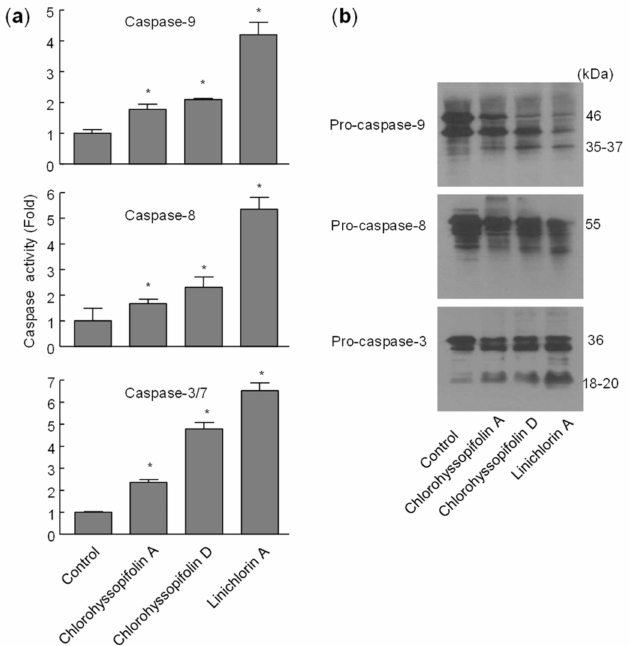
Figure 7. Chlorohyssopifolins A ( 1 ) and D ( 4 ) and linichlorin A ( 6 ) induce activation and processing of caspases in U-937 cells. ( a ) Cells were treated with 10 µ M of the indicated guaianolide, harvested at 24 h and cell lysates were assayed for caspase-9, caspase-8 and caspase-3 / 7 activities using colorimetric substrates. Results are expressed as factorial increases in caspase activity compared with the control. Values represent means ± S.D. of two independent experiments each performed in triplicate. * p < 0.05, significantly di ff erent from untreated control. ( b ) Processing of caspases in response to chlorohyssopifolins A ( 1 ) and D ( 4 ) and linichlorin A ( 6 ). Cells were incubated with 10 µ M of the indicated guaianolide for 24 h and the corresponding caspases were determined by Western blot